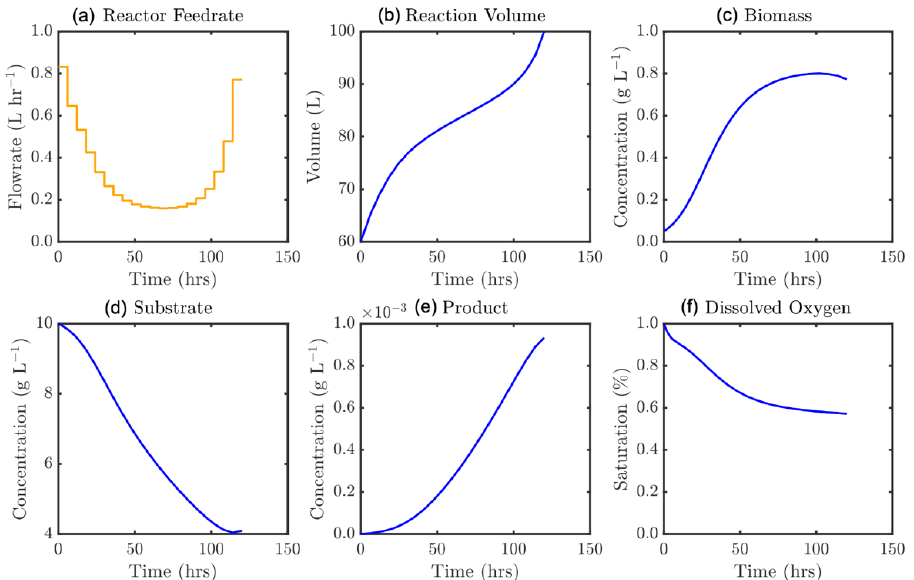
Figure 10. Optimal feedrate profile ( a ) and corresponding model states, ε = 120 h: ( b ) culture volume, and concentrations of ( c ) biomass, ( d ) substrate, ( e ) product, and ( f ) dissolved oxygen.